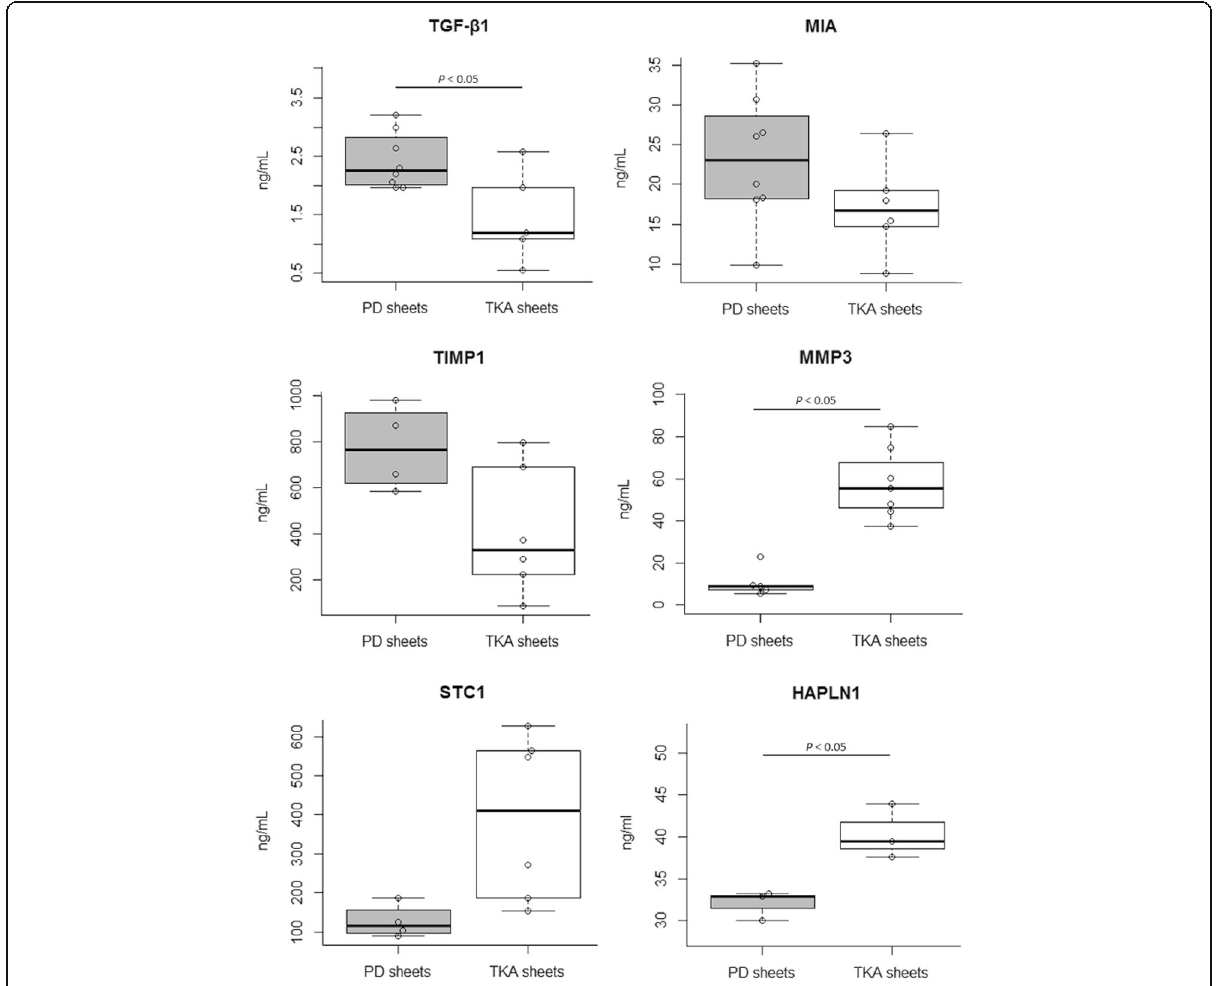
Fig. 5 A combination of box and strip plot of the concentrations of humoral factors secreted by PD sheets and TKA sheets. Each circle indicates the average value for a single donor. Upper and lower boxes represent the 25 and 75 percentiles, lines inside the boxes are medians, upper and lower whiskers represent 1.5 times the interquartile range, and circles outside of whiskers represent outliers. PD sheets produced significantly higher concentrations of TGF- β 1, and TKA sheets produced significantly higher concentrations of MMP3 and HAPLN1. * P <